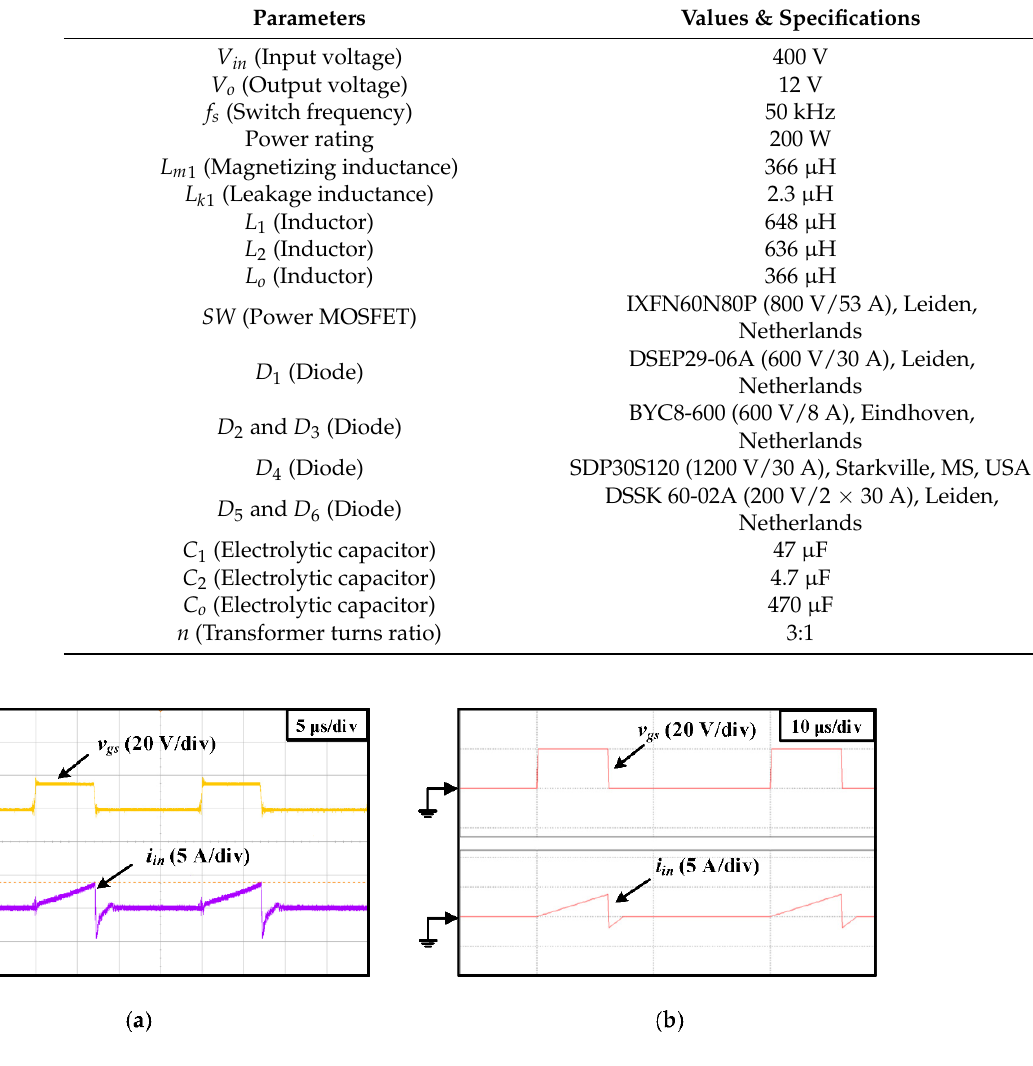
Figure 13. The waveforms of the control signal and the corresponding input current: ( a ) measured waveform, ( b ) simulated results.